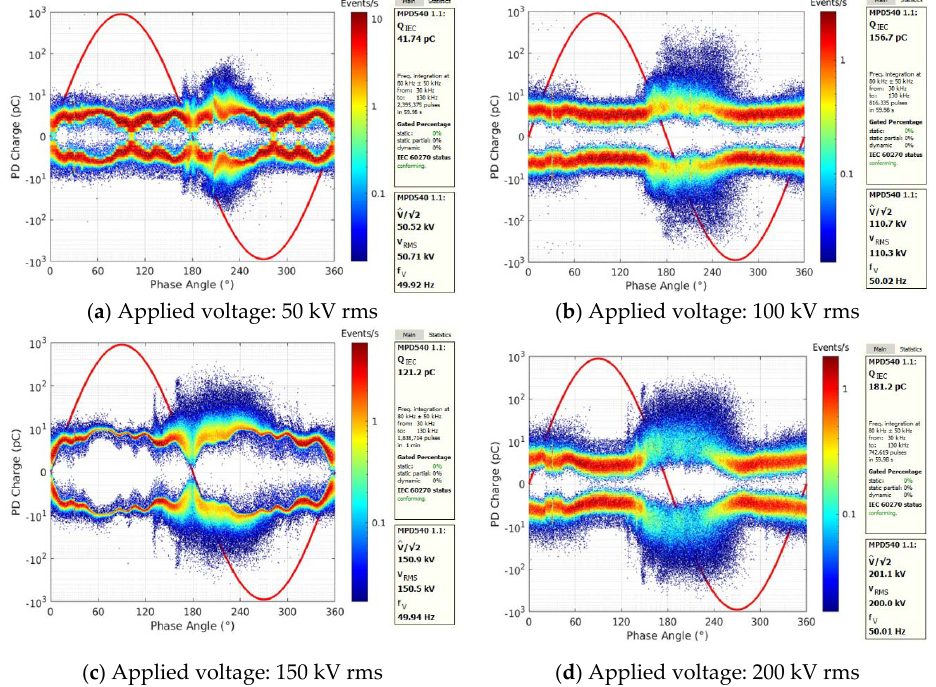
Figure 6. PD measurement of a gas insulated line demonstrator filled with 3 bar CO 2 —clean system— measured directly with the high voltage divider coupling capacitor at applied rms voltages of ( a ) 50 kV, ( b ) 100 kV, ( c ) 150 kV, and ( d ) 200 kV. Close investigation of the PD measurement indicated that